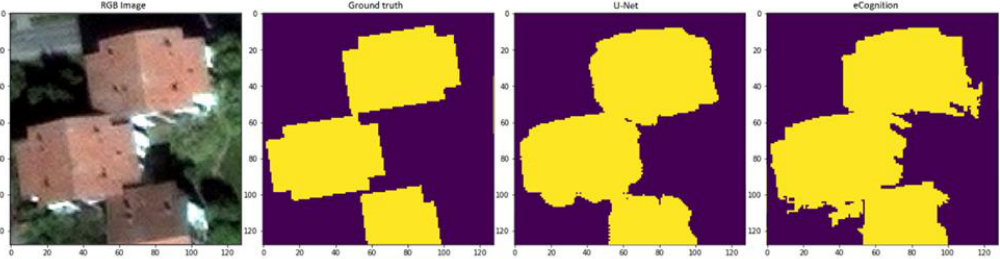
Figure 26. Examples of identifying tall objects.